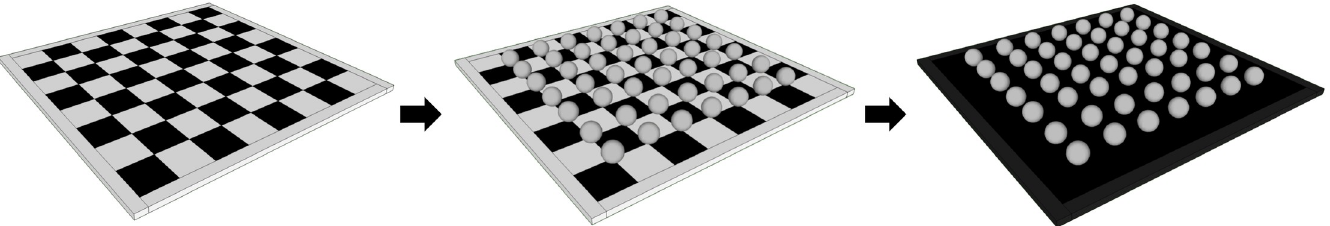
Fig 1. The idea of developing a novel alignment tool stemming from the concept of a checkered board. This study used the reflective markers which can be identified by MMTS in its coordinate system.